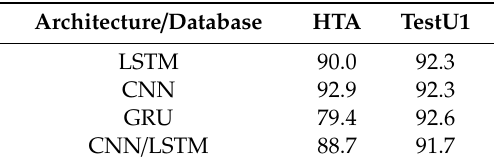
Test accuracy results when training on the TrainU1 dataset while using only accelerometer measurements.